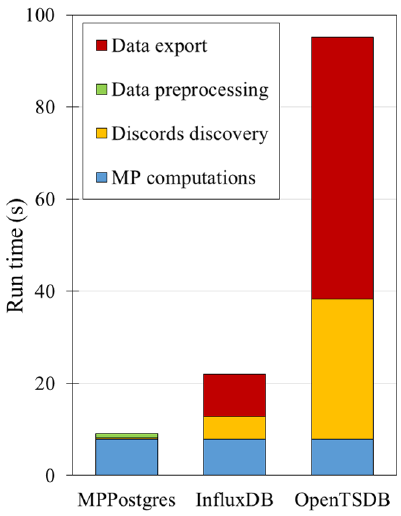
Figure 17. Implementation of the active electricity consumption detection case in MPPostgres.